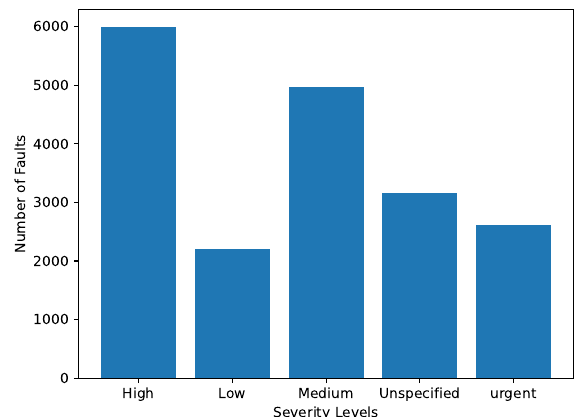
Figure 2. The fault severity levels for edge